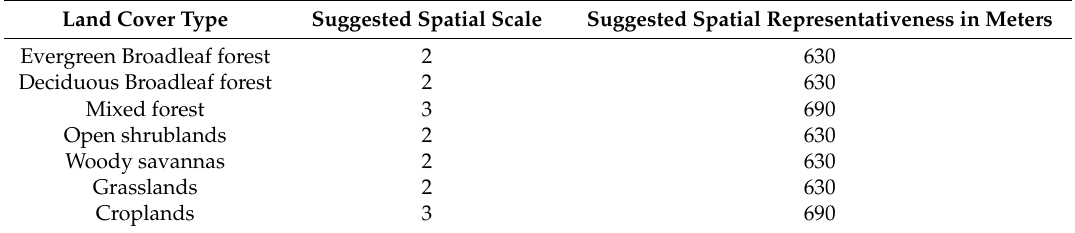
Table 3. Spatial representativeness of MODIS 500 m albedo product for different land cover types.